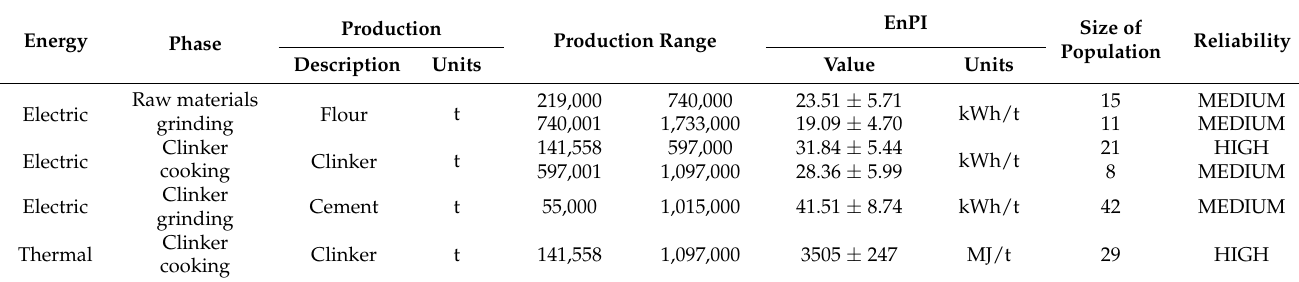
Table 3. NACE 23.51: statistical parameters of linear regression of site consumptions for second-level EnPIs.